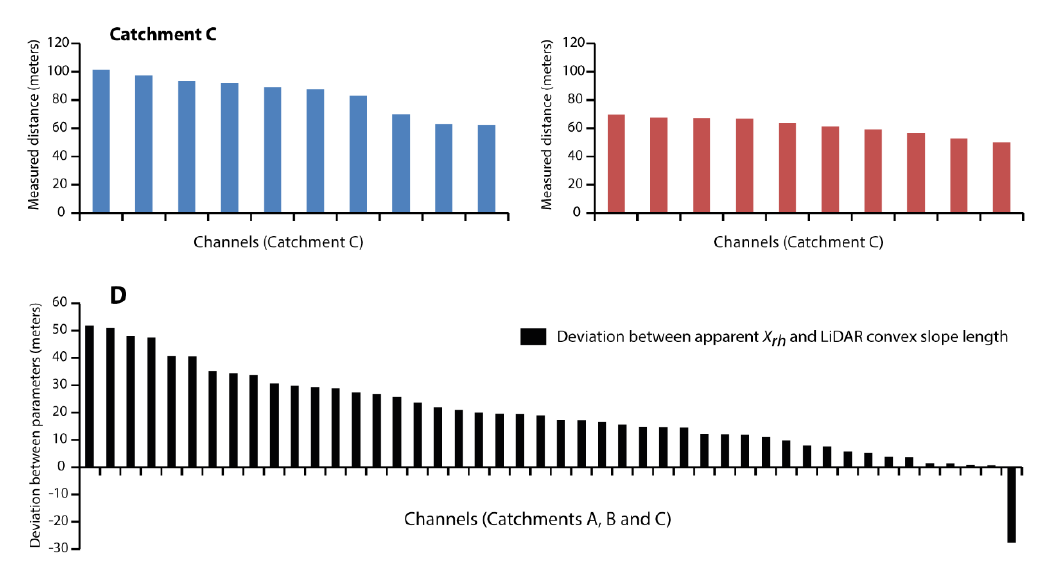
Figure 7. ( A – C ) apparent X rh and LiDAR convex slope length for each of the 46 measured first-order channels. Results are organized in catchments, and ordered from the highest to lowest value measured in each catchment; ( D ) deviation between the measured values of the apparent X rh and the LiDAR convex slope length, ordered from highest to lowest value.